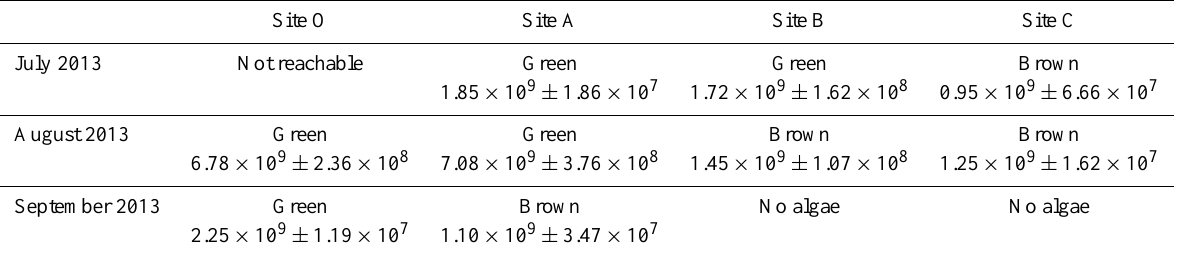
Table 1. Average 16S rRNA gene copy numbers of Gallionella detected per gram of wet weight algae sampled at sites O, A, B, and C, and at three sampling times in 2013 and measured by quantitative PCR ( n = 3, ±